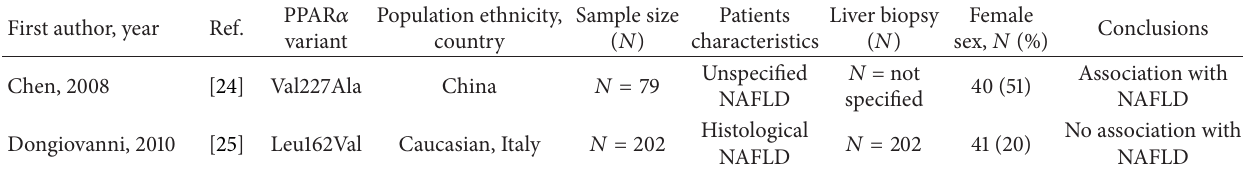
Table 1: Characteristics of the studies on the association between the PPAR 𝛼 polymorphisms and nonalcoholic fatty liver disease. First author,